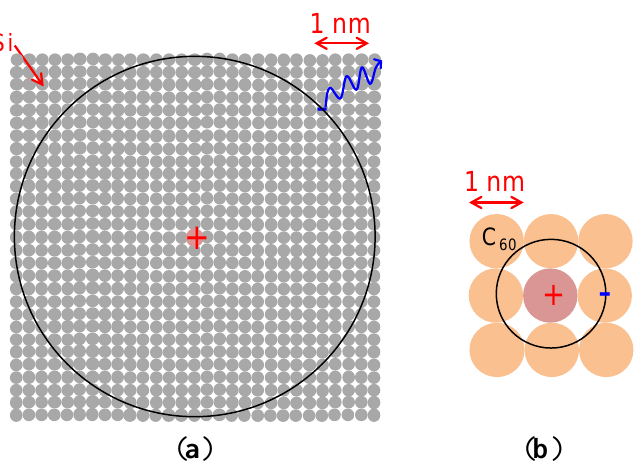
CO -doping in C . Cs CO 3+ is represented by the red 2 3 60 2